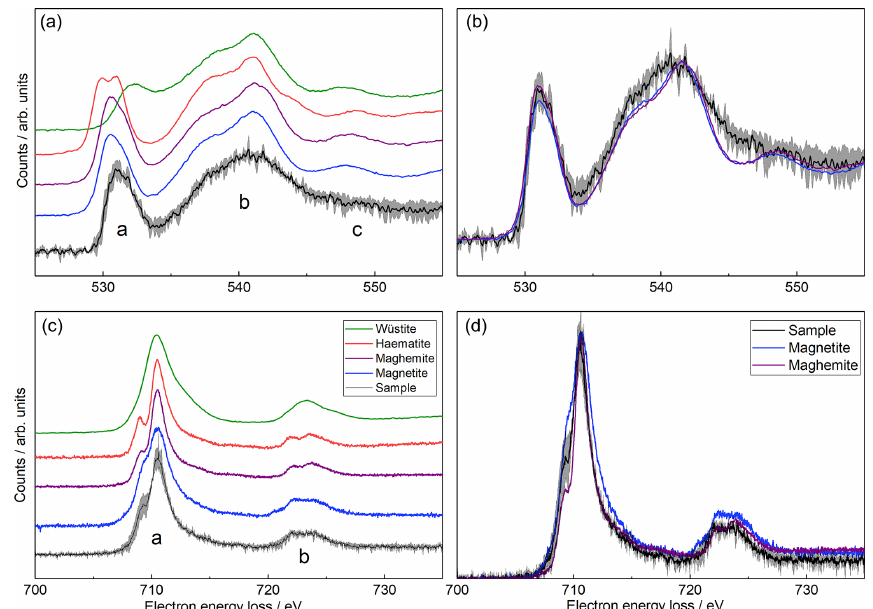
Figure 3. Electron energy loss spectra measured with the TEM compared to spectra for iron oxide standards (Brown et al., 2017, 2001). (a, b) Oxygen K-edge. (c, d) Iron L-edge. Grey shaded regions indicate the experimental uncertainty. The (a) and (c) panels show the spectra offset for clarity, and (b) and (d) panels show the same spectra (for the sample, magnetite and maghemite)